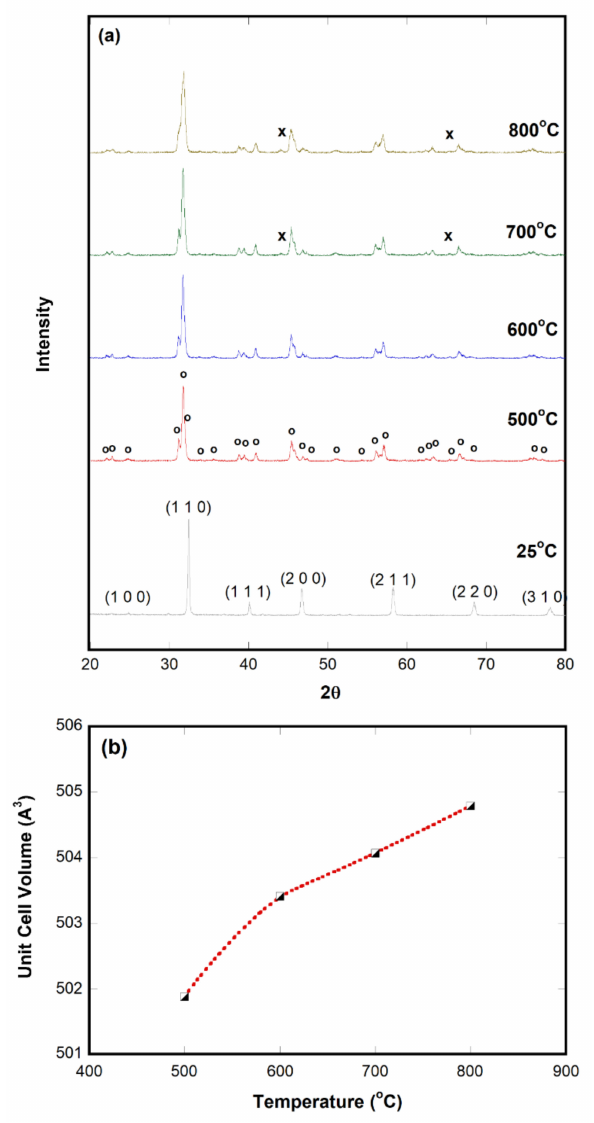
Figure 1. In-situ XRD results of SrFeO 3 − δ : ( a ) In-situ XRD powder pattern and ( b ) unit cell volume at 500 ≤ T ≤ 800 ◦ C. The symbols indicate Fe metal (x) and brownmillerite